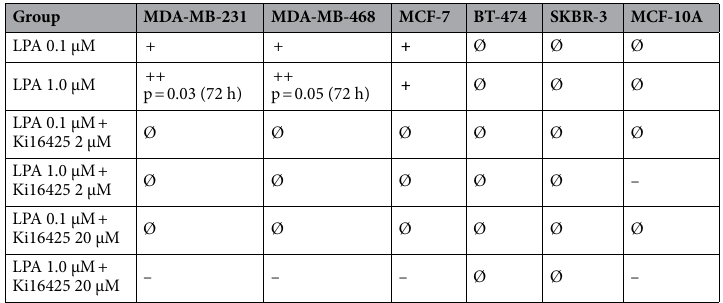
Table 3. Cell proliferation. Effect of lysophosphatidic acid (LPA) 18:1 and the LPA receptor 1, 3 (and 2) inhibitor Ki16425 on cell proliferation after 24 h, 48 h and 72 h of different human breast cancer cell lines. LPA stimulated significantly proliferation of MDA-MB-231 and MDA-MB-468 cells, and trended to stimulate proliferation of MCF-7 cells. n = 3 replicate experiments, a p-value ≤ 0.05 was considered significant (Kruskal– Wallis test and post-hoc Dunn’s test). Ø: no effect; +: stimulatory trend; ++: statistically significant stimulation; –: inhibitory trend. For LPA 0.1 μM and LPA 1.0 μM, stimulation was compared to the control group; for LPA